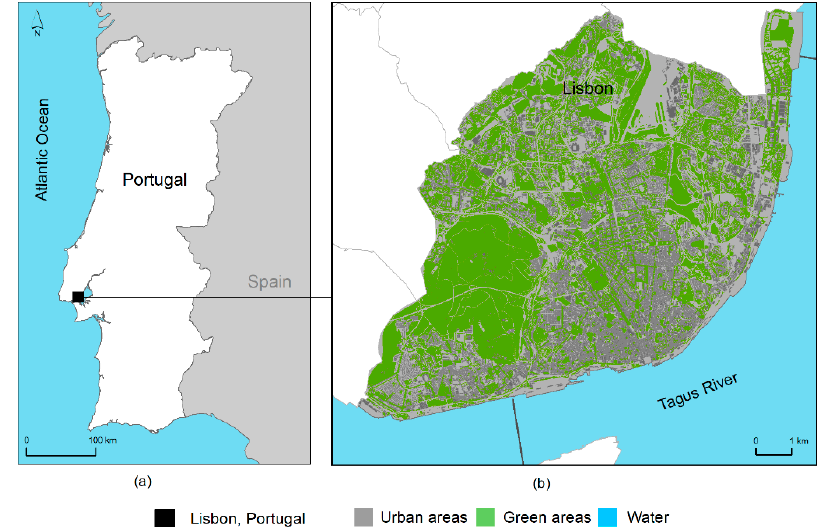
Figure 1. Location of the study area, Lisbon, Portugal ( a ), and the city’s land use land cover map ( b ).